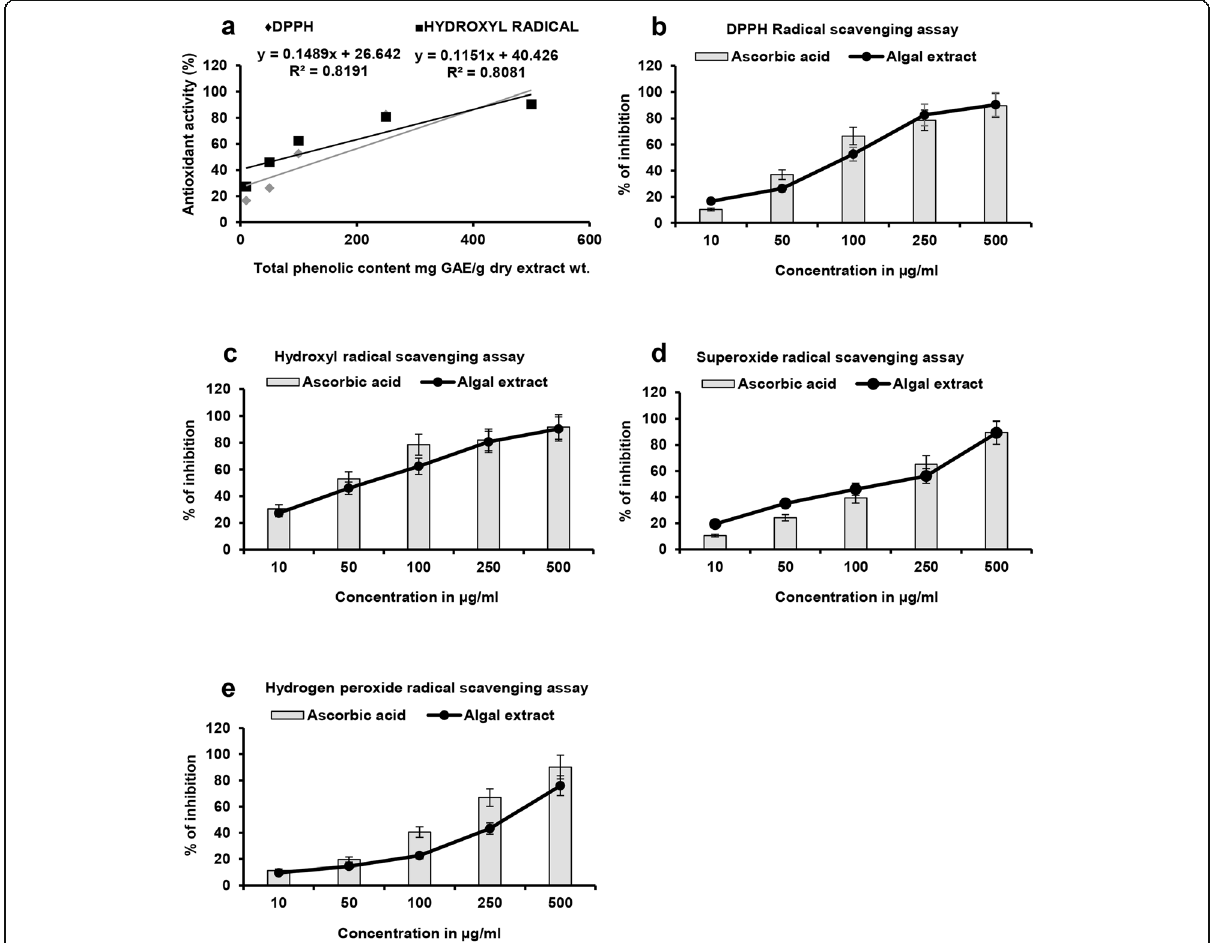
Fig. 2 Correlations between antioxidant capacity and total phenols of C. vulgaris extract ( a ). Different radical scavenging activity of methanol extract of the C. vulgaris such as DPPH radical scavenging activity ( b ), hydroxyl radical scavenging activity ( c ), superoxide radical scavenging activity ( d ), and hydrogen peroxide radical scavenging activity ( e )